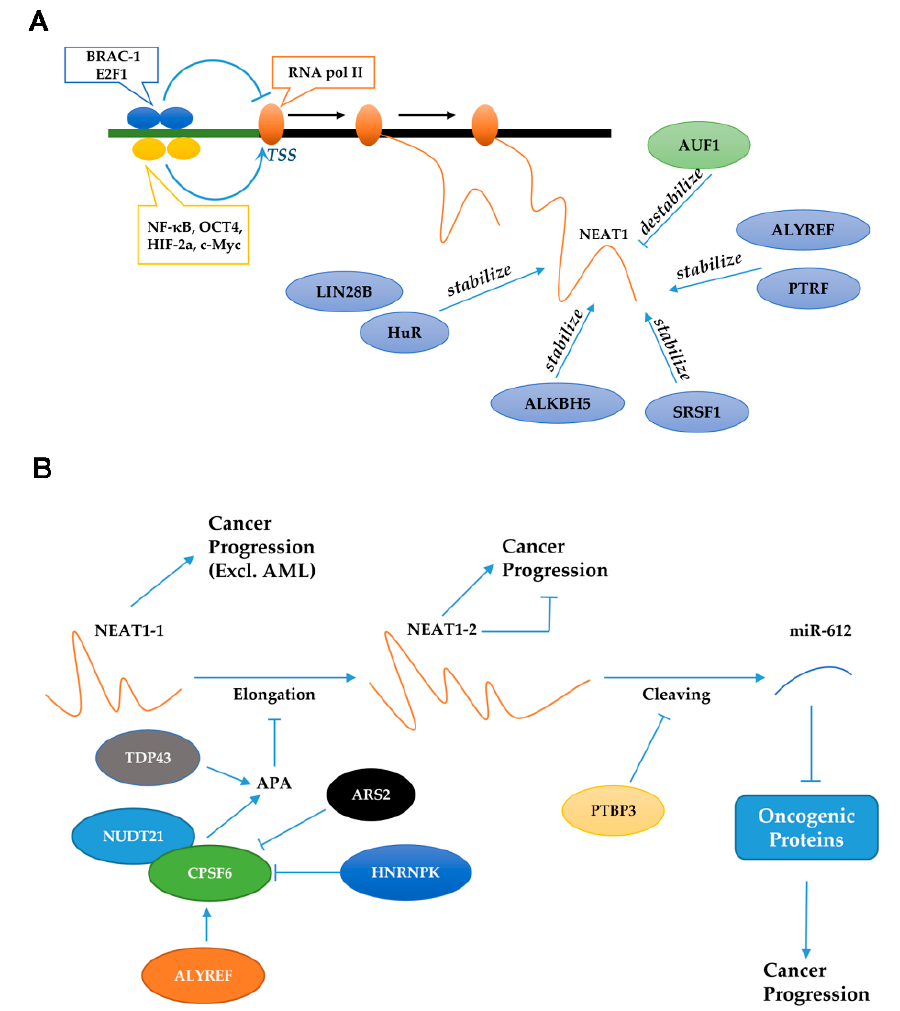
Figure 3. Regulation of NEAT1 at transcriptional level ( A ) and posttranslational level ( B ). ( A ) After being regulated by transcriptional activator or repressor, NEAT1 can also be stabilized or destabilized by some proteins. ( B ) When the polyadenylation (APA) of NEAT1-1 is activated, the transcription site cannot cross the end of NEAT1-1. Consequently, the expression level of NEAT1-1 will be elevated, and the generation of NEAT1-2 will be inhibited. In addition, PYBP3 can inhibit the cleaving of NEAT1-2 to reduce the generation of miR-612, thereby promoting cancer